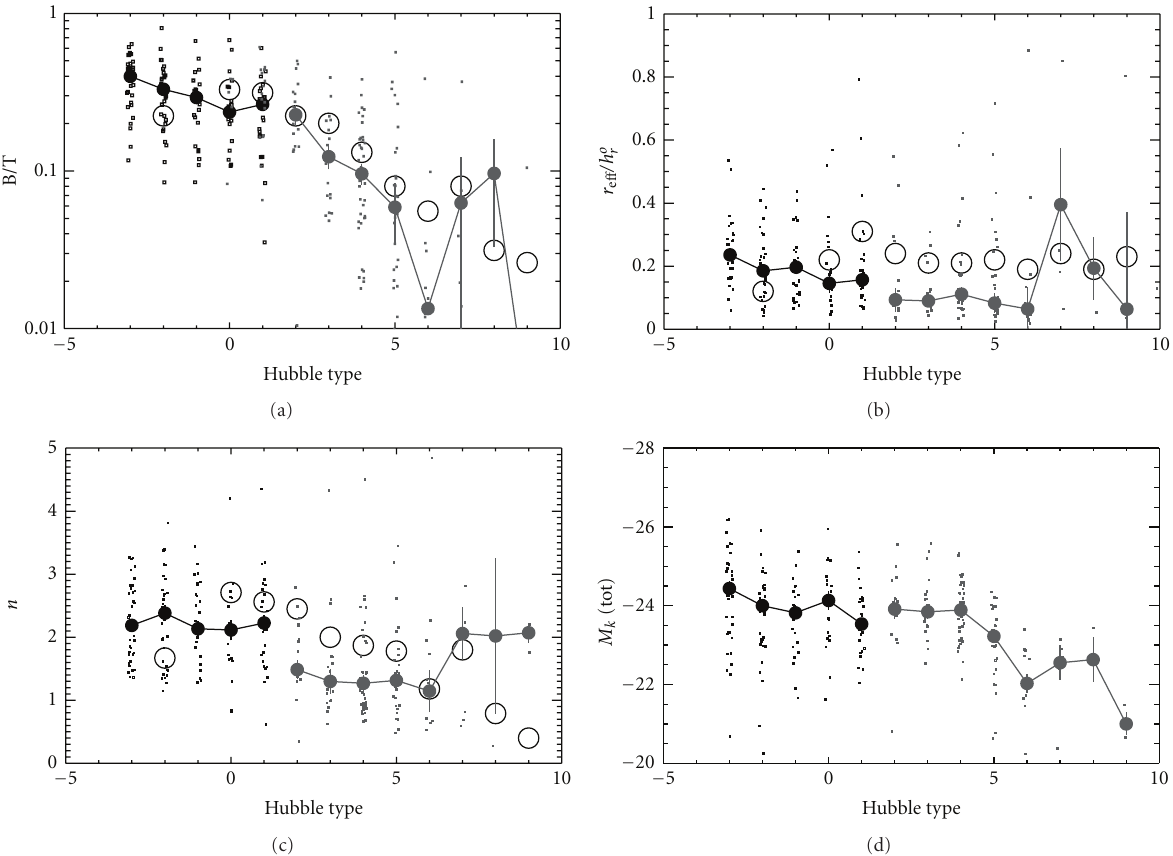
Figure 12: As a function of the Hubble type are shown (a) the dust corrected B/T , (b) the S´ersic index n , (c) the ratio of the e ff ective radius ), and (d) the total absolute galaxy magnitude corrected for galactic extinction of the bulge ( r e ff ) divided by the scale length of the disk ( h o r ). The small symbols show the measurements for the individual galaxies (with a small random horizontal o ff set), filled circles show the ( M o tot median values in each Hubble-type bin, and large open circles are the median values from Graham and Worley ([64]; their value for S0s refers to types − 3, − 2, − 1 and is here drawn at T = − 2). The error bars are taken to be the sample standard deviations in each bin divided by square root of the number of galaxies in each bin. Dark symbols are for the galaxies in NIRS0S and light symbols for the galaxies in OSUBSGS. In a slightly di ff erent form, the same figure was originally published by Laurikainen et al.